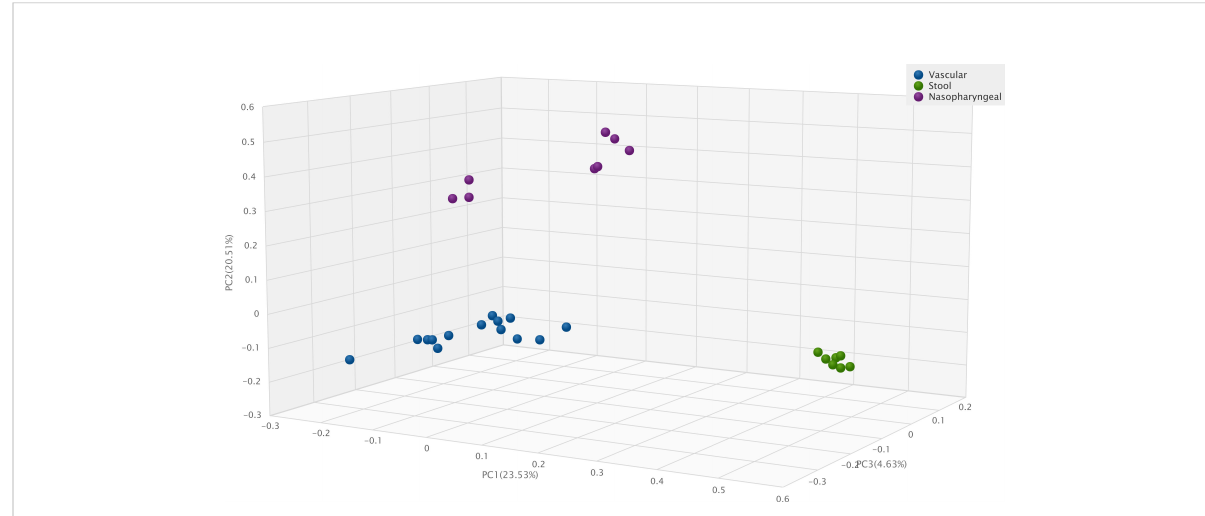
FIGURE 5 Jaccard Beta Diversity Principal Coordinate Analysis of human vascular, human stool and human nasopharyngeal samples.